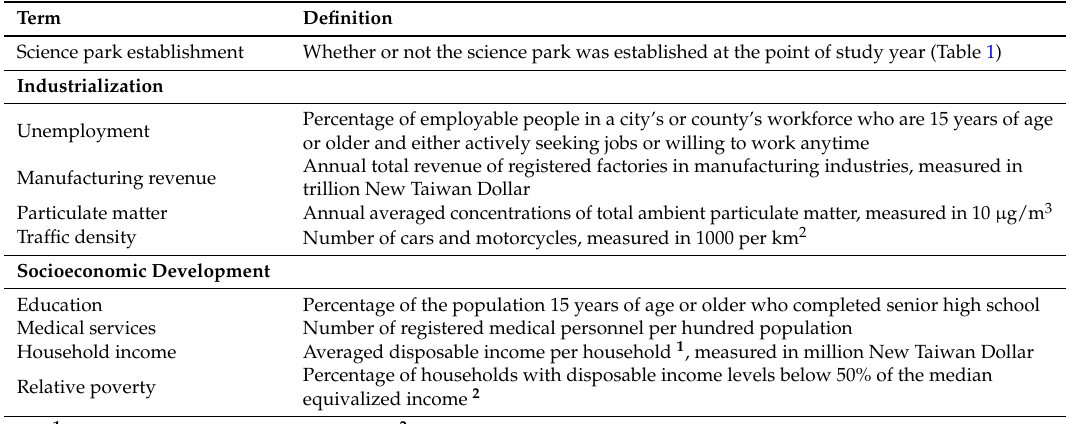
Table 3. Definition of the selected determinants of